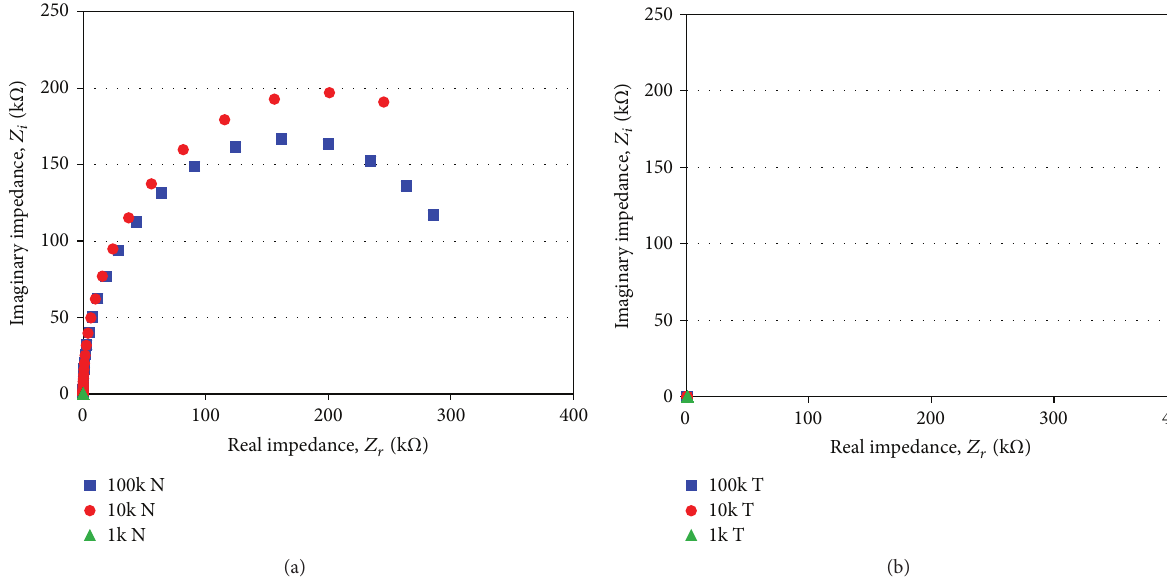
Figure 5: Effect of corrosion inhibitors (N: NO 2− , T: TEA) on AC impedance measurement for the passive film formed at 0 V (SCE) in deaerated tap water at 30 ∘ C. (a) Nitrite addition. (b) TEA